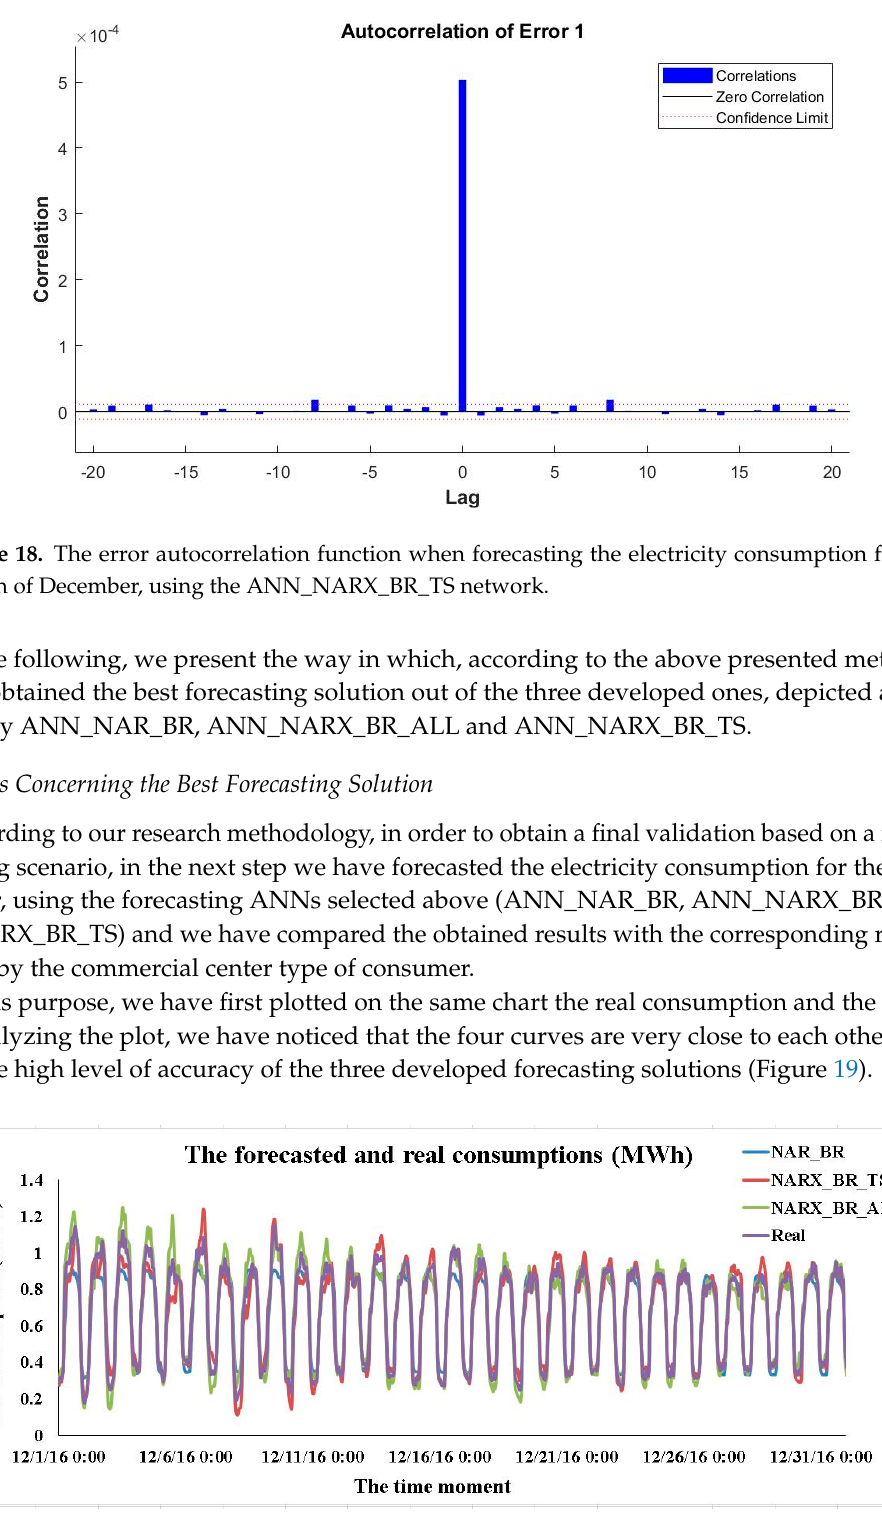
Figure 20. The absolute values of the differences between the real consumption and each of the three forecasted ones. Based on this second chart, we are able to identify that the network that provides the best forecasting results, as close as possible to the real values, is ANN_NARX_BR_ALL, as in this case the absolute values of the differences are closest to the zero value. On the second place is situated the